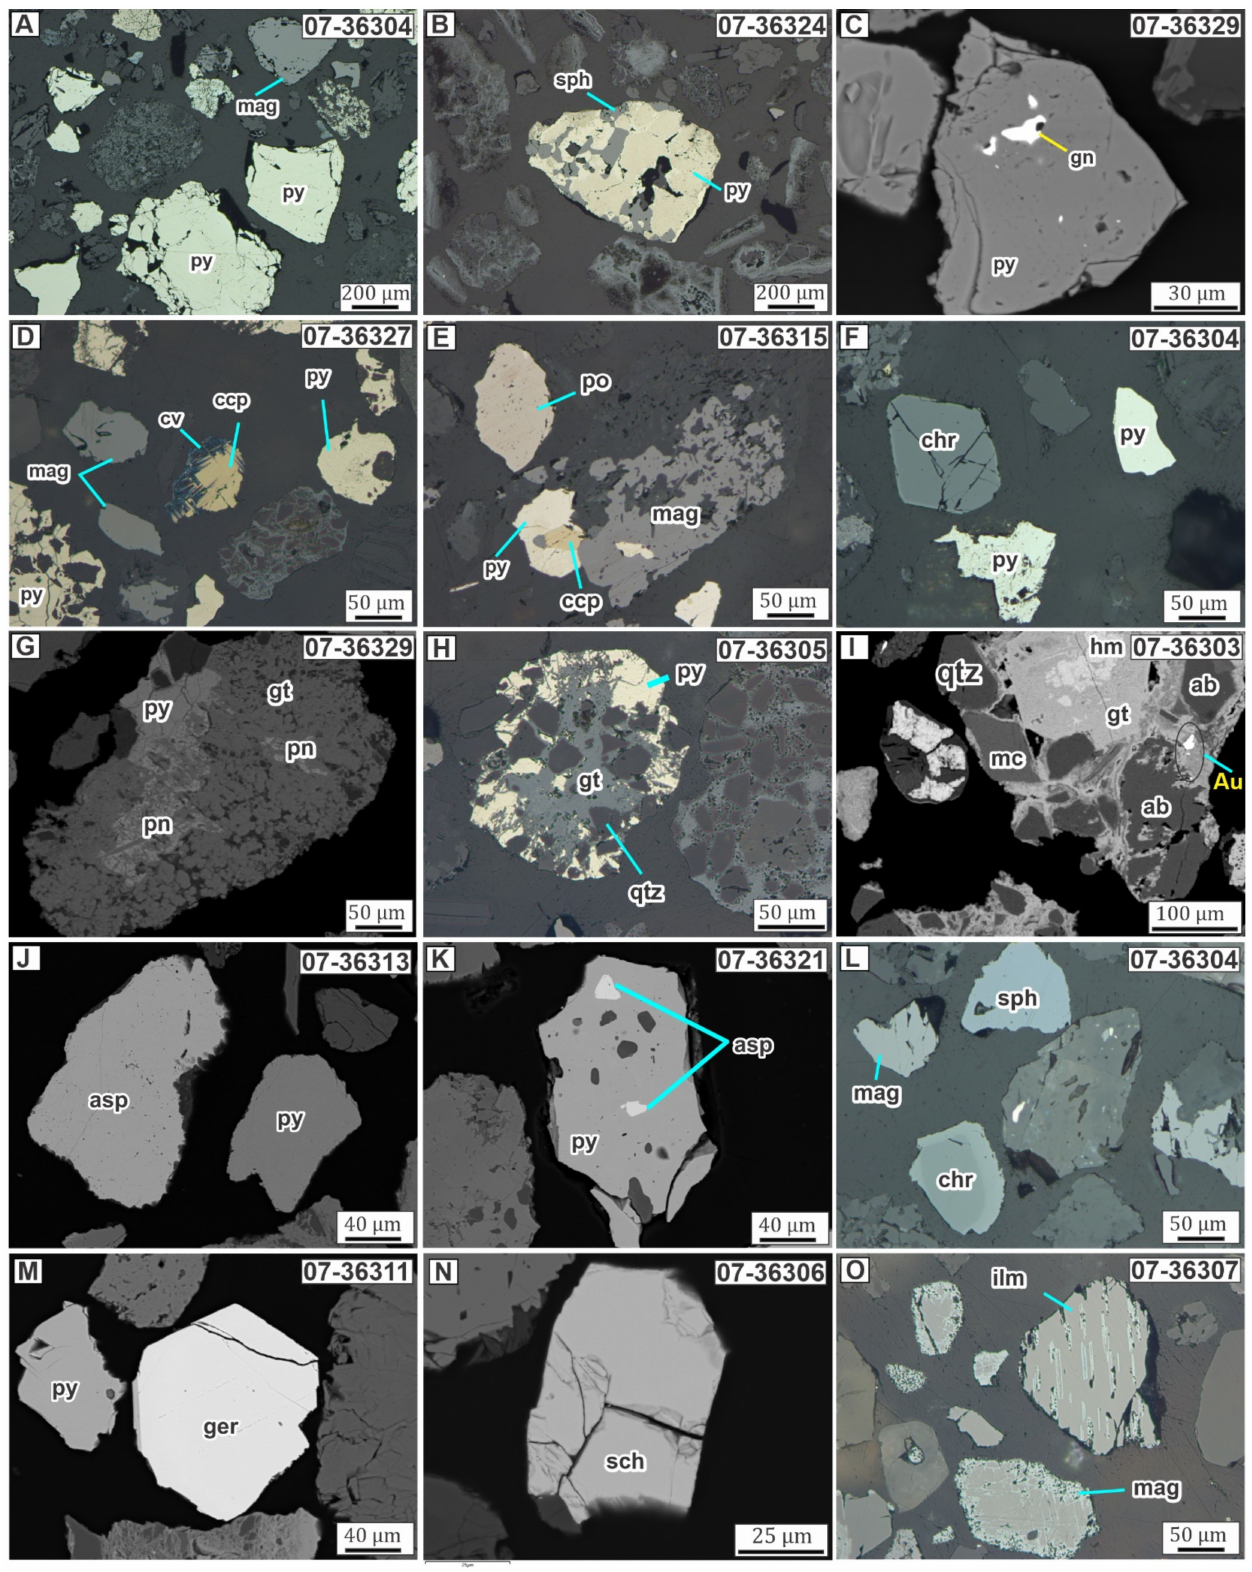
Figure 11. Reflected light ( A , B , D – H , L , O ) and BSE-SEM images of detrital ( C , G , J , K , M , N ) and diagenetic ( H ) sulfides, gold (Au in ( I )), and opaque oxide minerals in the Permian cover. Mineral abbreviations: py = pyrite, mag = magnetite, sph = sphalerite, gn = galena, ccp = chalcopyrite, cv = covellite, po = pyrrhotite, sch = scheelite, asp = arsenopyrite, ger = gersdorffite, qtz = quartz, pn = pentlandite, gt = goethite, ilm = ilmenite, chr = chromite, Au =